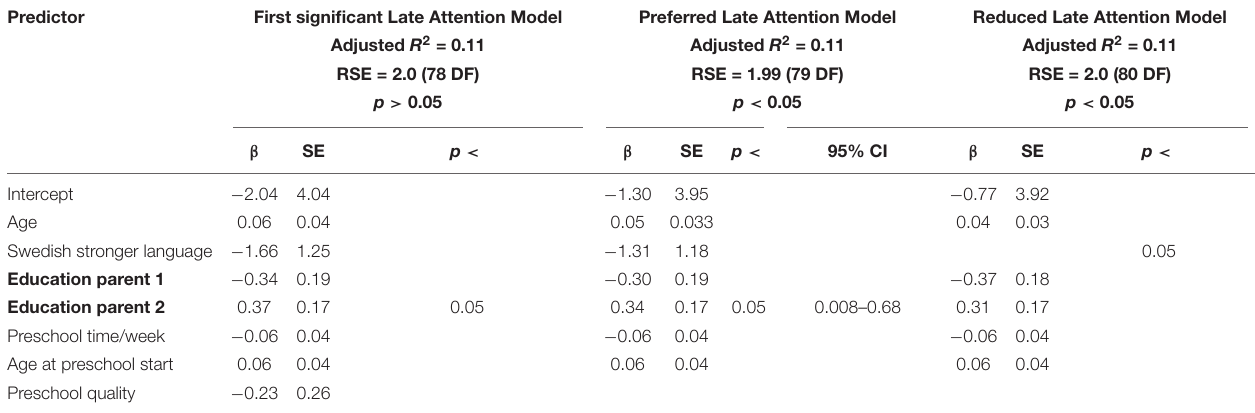
TABLE 7 | Model comparison for late selective attention.